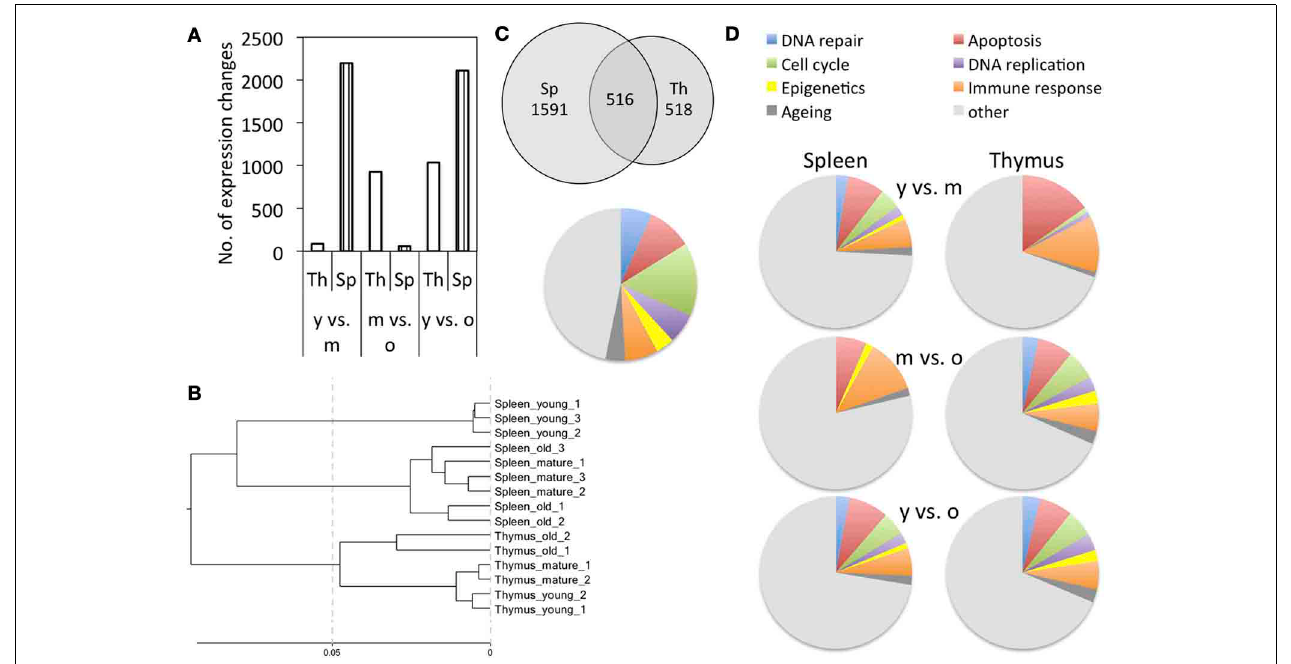
FIGURE 1 | Cluster analysis and functional classification of gene expression results. (A) Number of differentially expressed genes when comparing different age groups; y is young, m is mature, and o is old. (B) Cluster analysis based on all probes represented on the BeadChip.